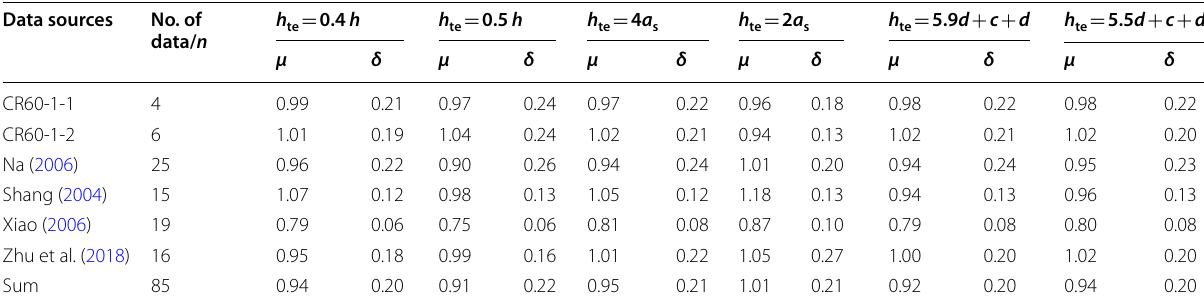
Table 10 Comparison results of w t max from RC beams with 400 MPa steel bars with w c1 max by the proposed methods. Data sources No. of data/ n